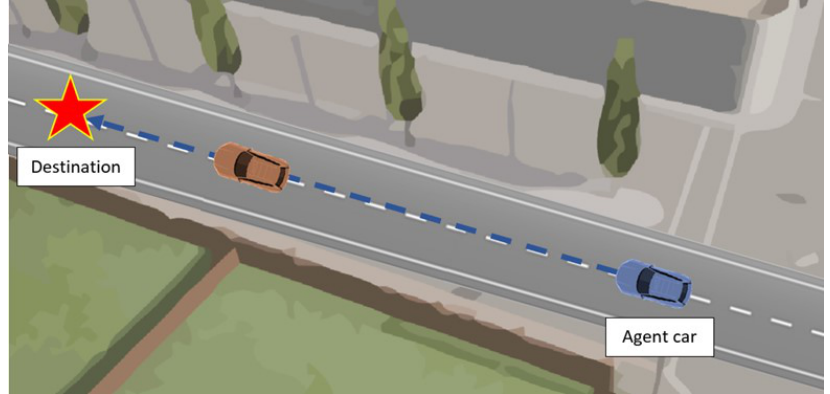
Figure 7. The scenario obstacle avoidance in low-speed control.